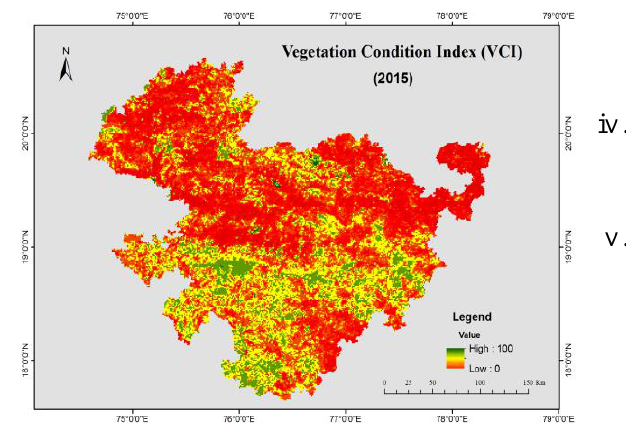
Figure 8. Spatial Distribution of Vegetation Drought (2015) After the separate analysis of both the indices, they were normalized for the further investigation. Both the data were converted (normalized) in the range of 0 to 1 and stacked before applying the counting method. Final results (Figure 9) were obtained by processing both the images simultaneously. The result represents that the maximum amount of severe drought was due to the adverse vegetation condition which affected greatly on various parts of the study area. 53% area of Marathwada was under intense vegetation-drought condition; whereas 40% area was influenced more due to the meteorological drought. Only 7% area was experienced the equal impact of VCI and